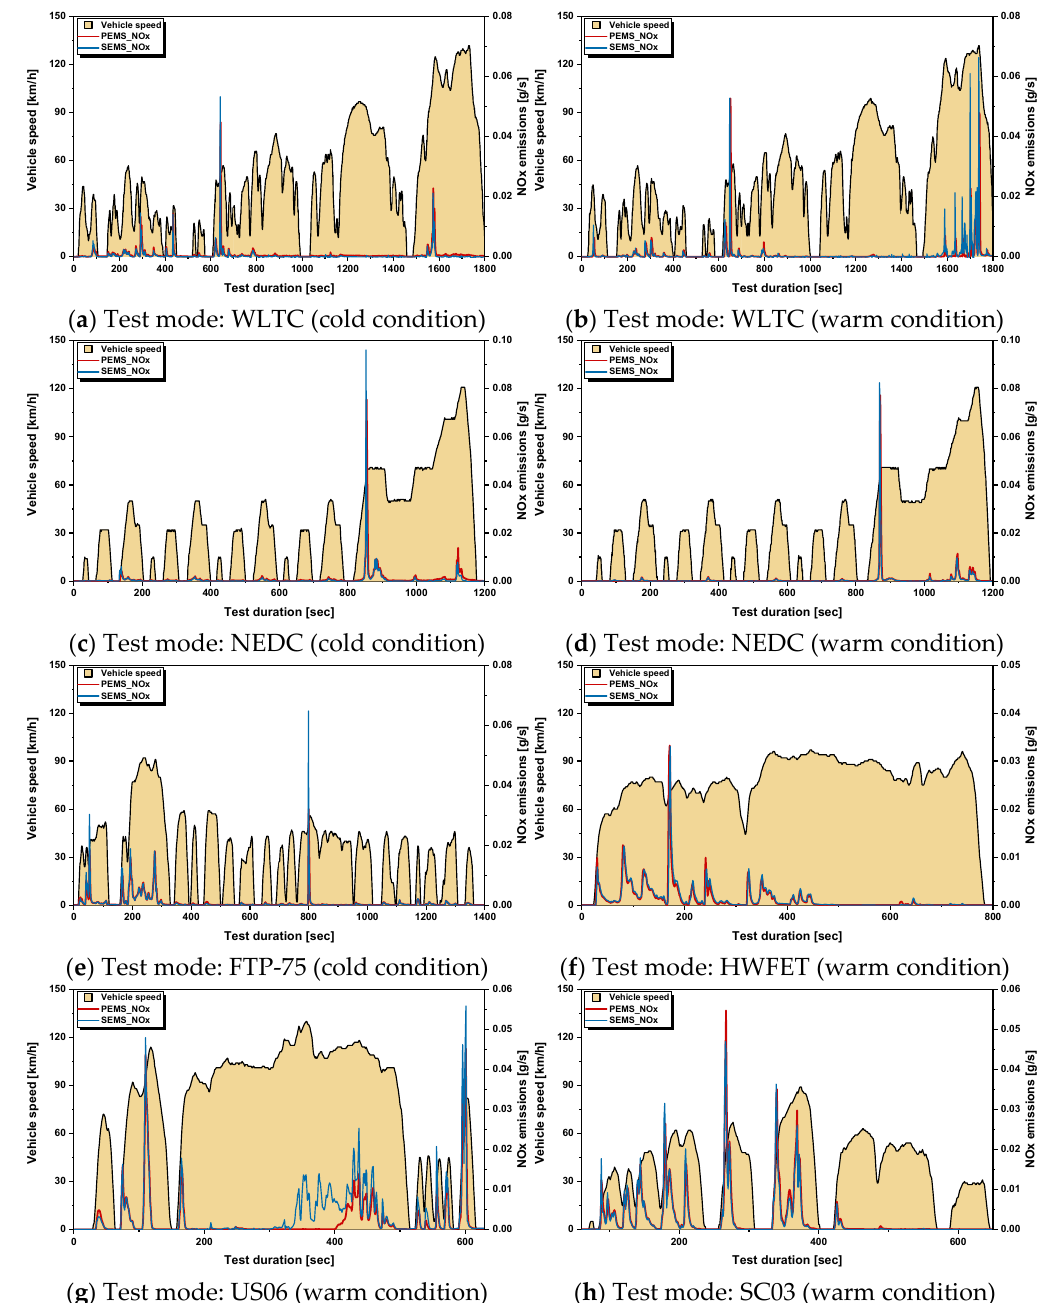
Figure 11. Real-time profiles of NOx emissions measured by the PEMS and SEMS equipment under various test modes in the